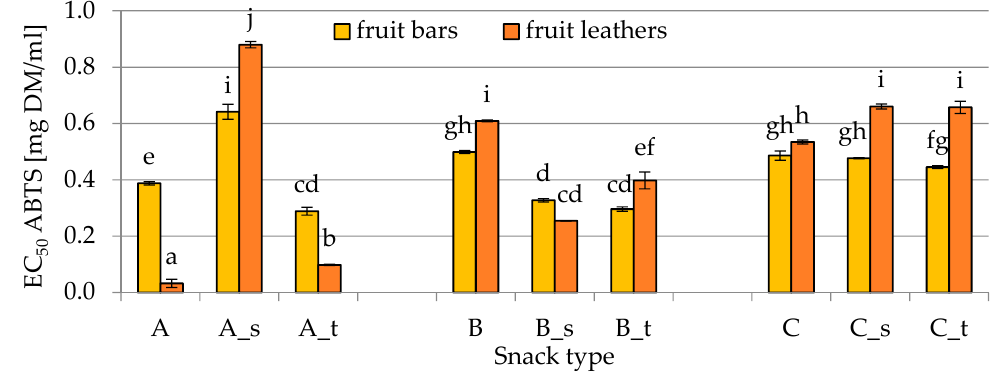
Figure 4. EC 50 of fruit bars and leathers (A, B, C—different composition; s—sucrose addition; t—trehalose addition) obtained using the ABTS method, as described in Section 4.2.4. Different letters above the columns indicate significant differences ( α = 0.05) between all considered samples.